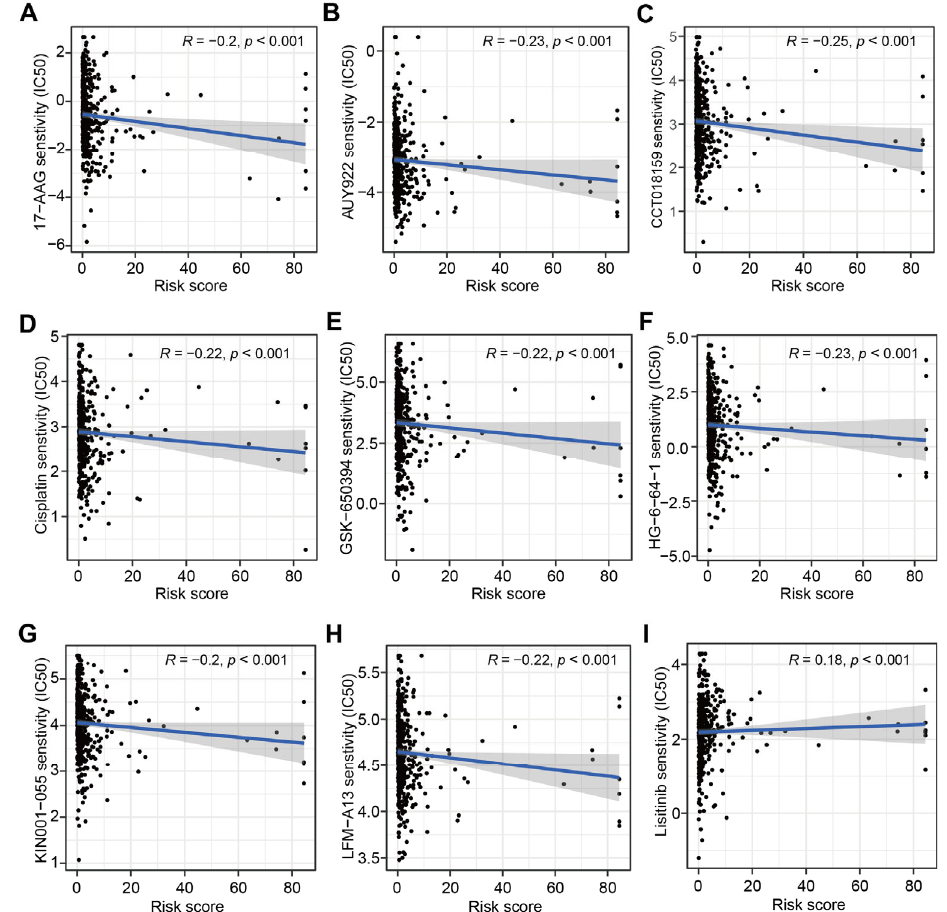
Figure 7. Correlation analysis between sensitivity of targeted therapy drugs and CRLs ‐ based risk score. ( A – I ) Correlation analysis between the IC50 value of 17 ‐ AAG ( A ), AUY992 ( B ), CCT018159 ( C ), Cisplatin ( D ), GSK ‐ 650394 ( E ), HG ‐ 6 ‐ 64 ‐ 1 ( F ), KIN001 ‐ 055 ( G ), LFM ‐ A13 ( H ), Lisitinib ( I ) and CRLs ‐ risk score.